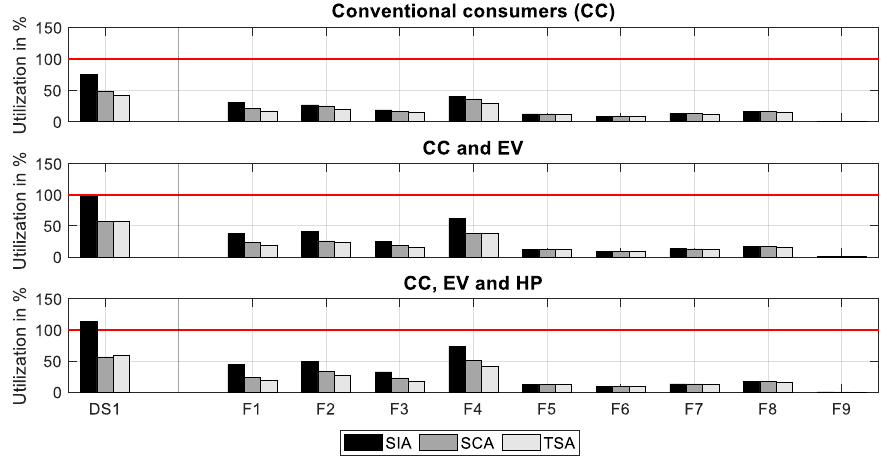
Figure 7. Comparison of various load approaches regarding the thermal utilization of the distribution substation’s transformer (DS1) as well as feeders (F1–F9) considering an EV- and HP-penetration of 5% supplied by the suburban LV grid.